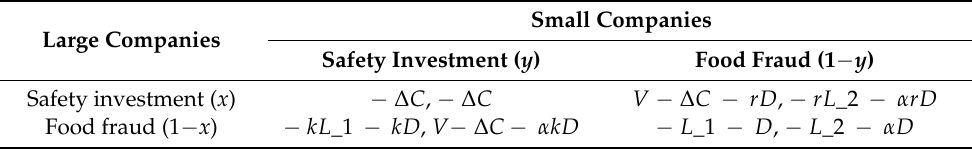
Table 3. Benefit matrix of food safety strategies for large and small